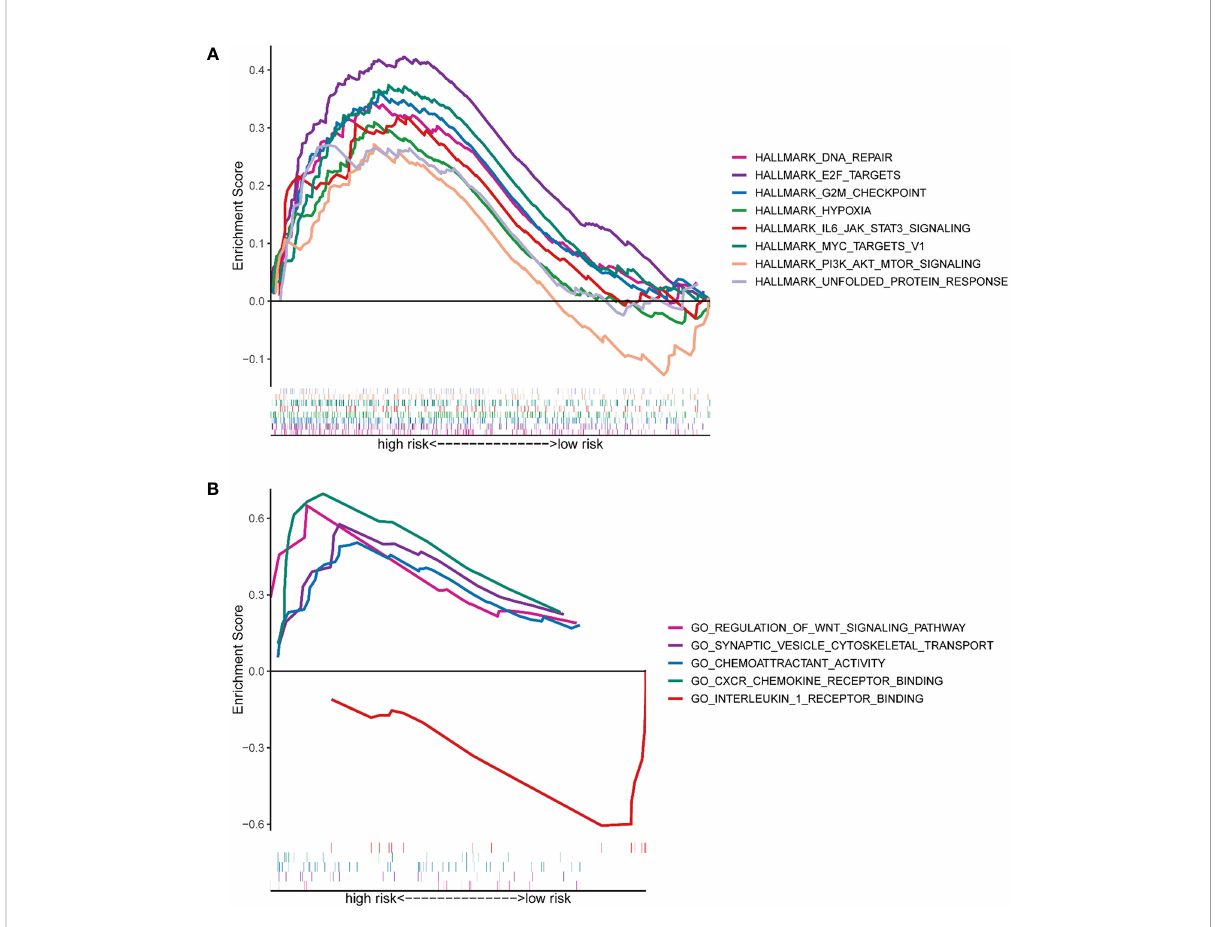
FIGURE 5 Functional prediction of the HRG-based signature via GSEA. (A) The hallmark gene set was enriched between the high- and low-risk groups. (B) The GO pathway set was enriched between the high- and low-risk